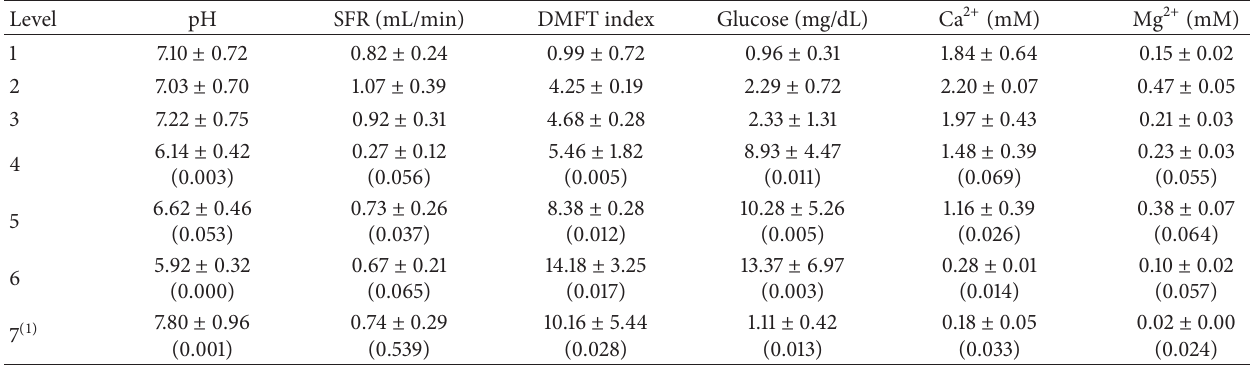
Table 1: pH, SFR, DMFT, glucose, and electrolytes of whole saliva from patients with TIDM, TIIDM, and Behc¸et disease compared with control groups.